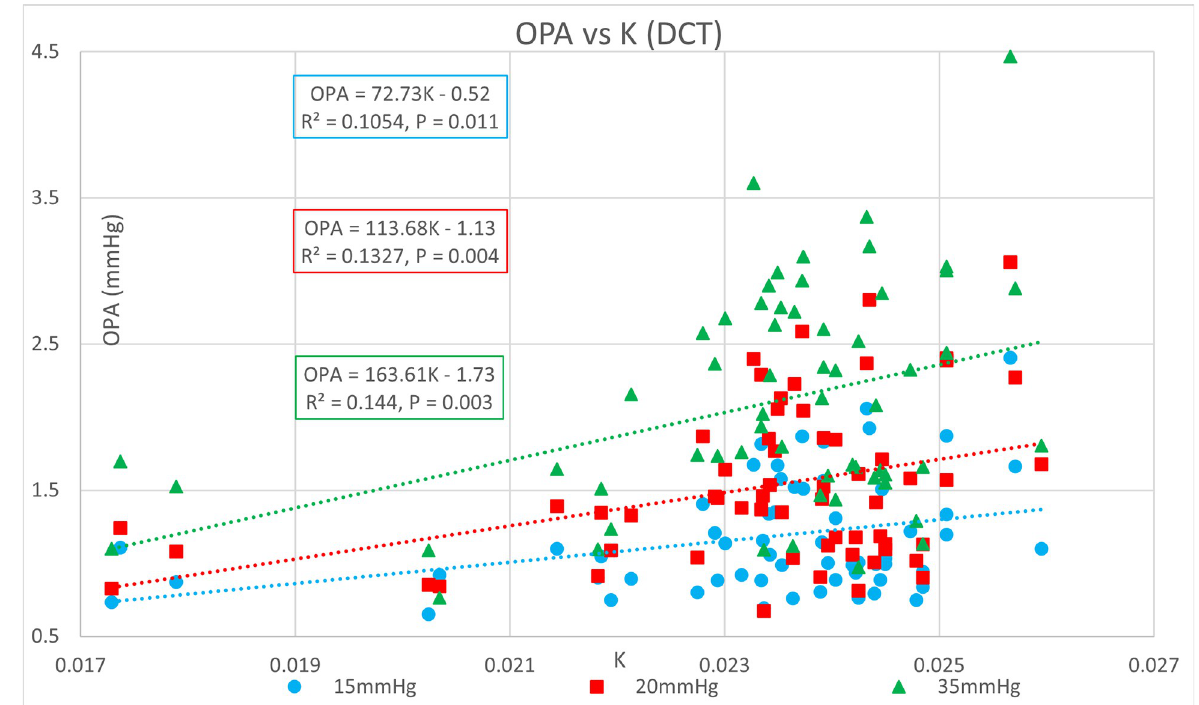
Fig 1. Positive correlation of OPA to estimated OR (K) for DCT measurements.